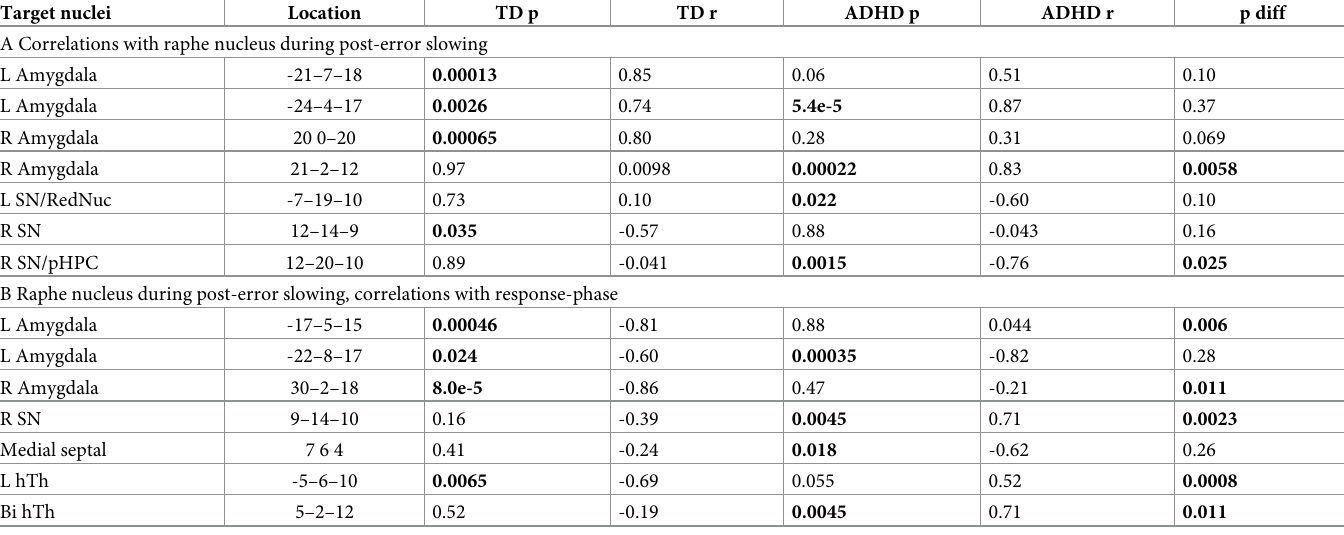
Table 4. Correlations with raphe